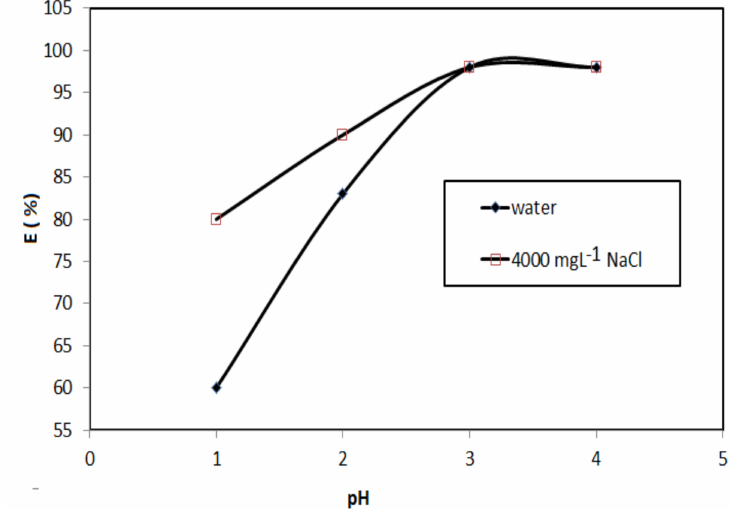
Figure 13. E ff ect of CR pH on the removal e ffi ciency for of QVP / AAm-Fe 3 O 4 at room temperature in the presence and absence of